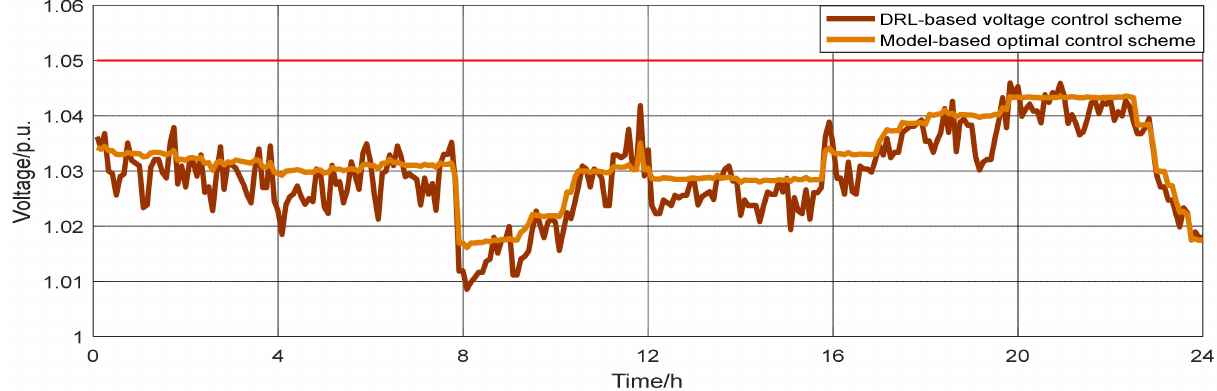
Figure 9. Voltage amplitude at bus 1 under different methods with no PV